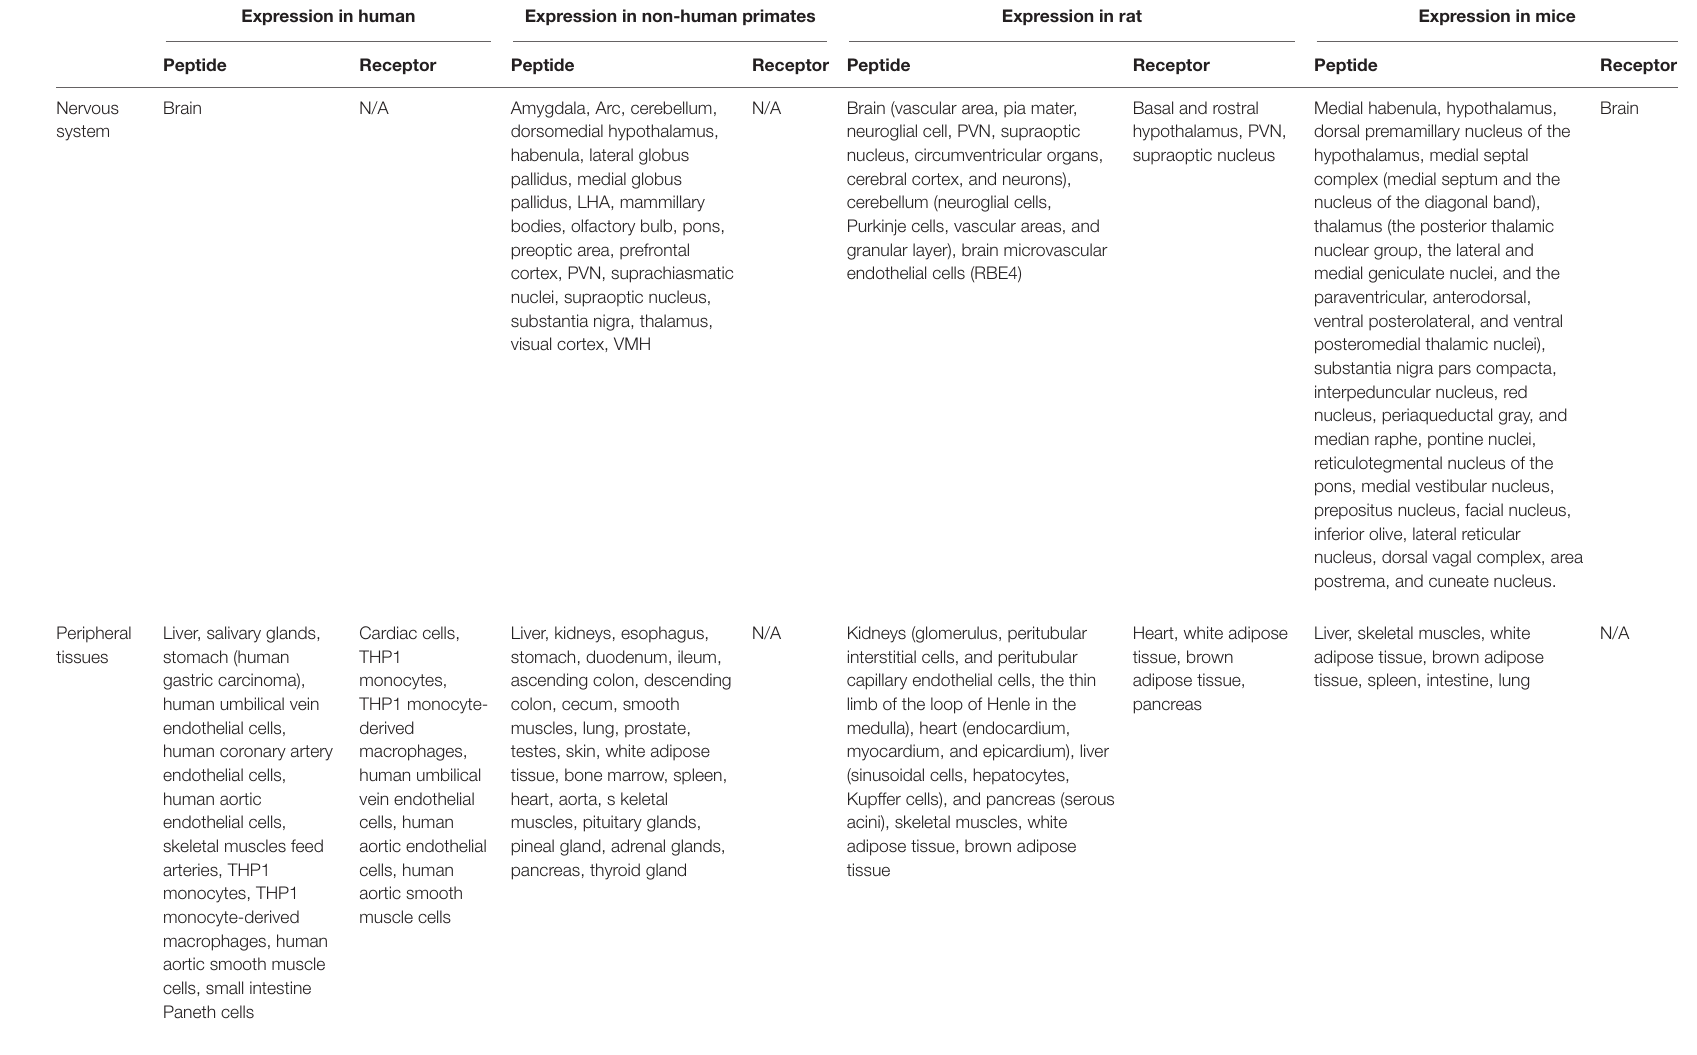
TABLE 3 | Expression of the adropin and GPR19 in humans, non-human primates, and rodents. Expression in